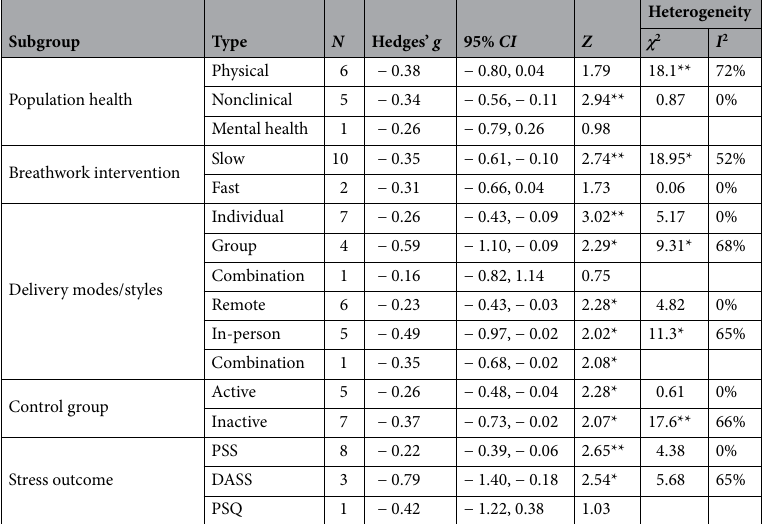
Table 1. Subgroup analyses on effect of breathwork on self-reported/subjective stress at post-intervention. *p < 0.05, **p < 0.01 . Heterogeneity not applicable where one study ( n = 1) analysed. There were no significant differences between